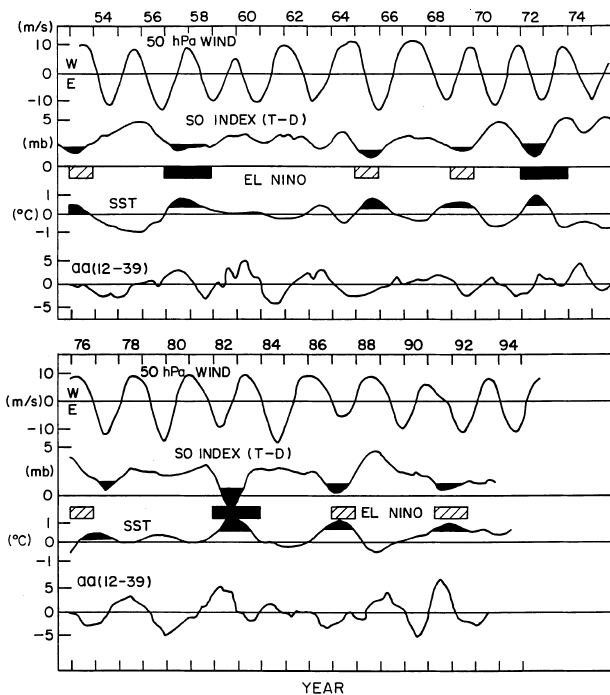
Fig. 11. The 12-monthly running of 50 hPa wind , Southern Oscilla- tion (SO)index (T-D) , equatorial eastern Pacific sea-surface temper- ature SST and aa (12–39) , for 1953–1975 in the upper panel and 1976–1995 in the lower panel . Minima of (T-D) and maxima of SST are shown black and coincide with El Nino events shown by rectangles ( solid = strong; hatched = moderate; blank = weak)